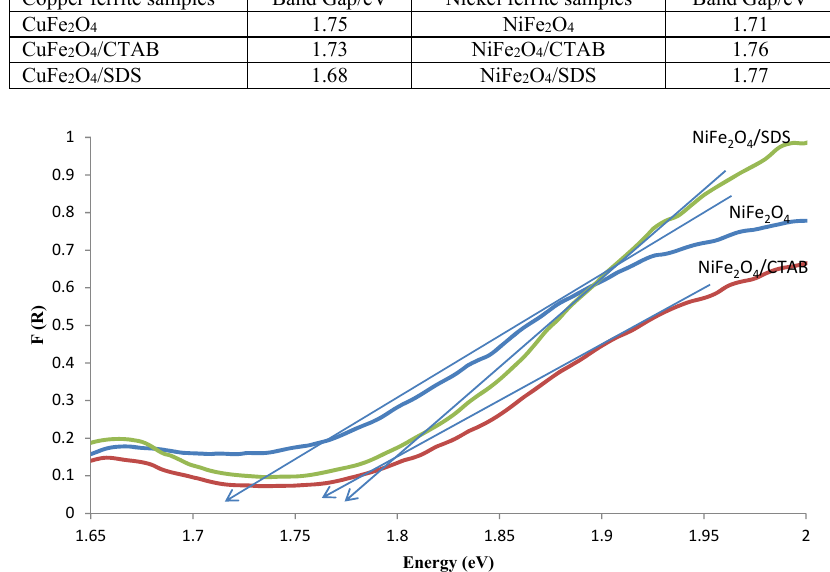
O samples: a)NiFe 2 4